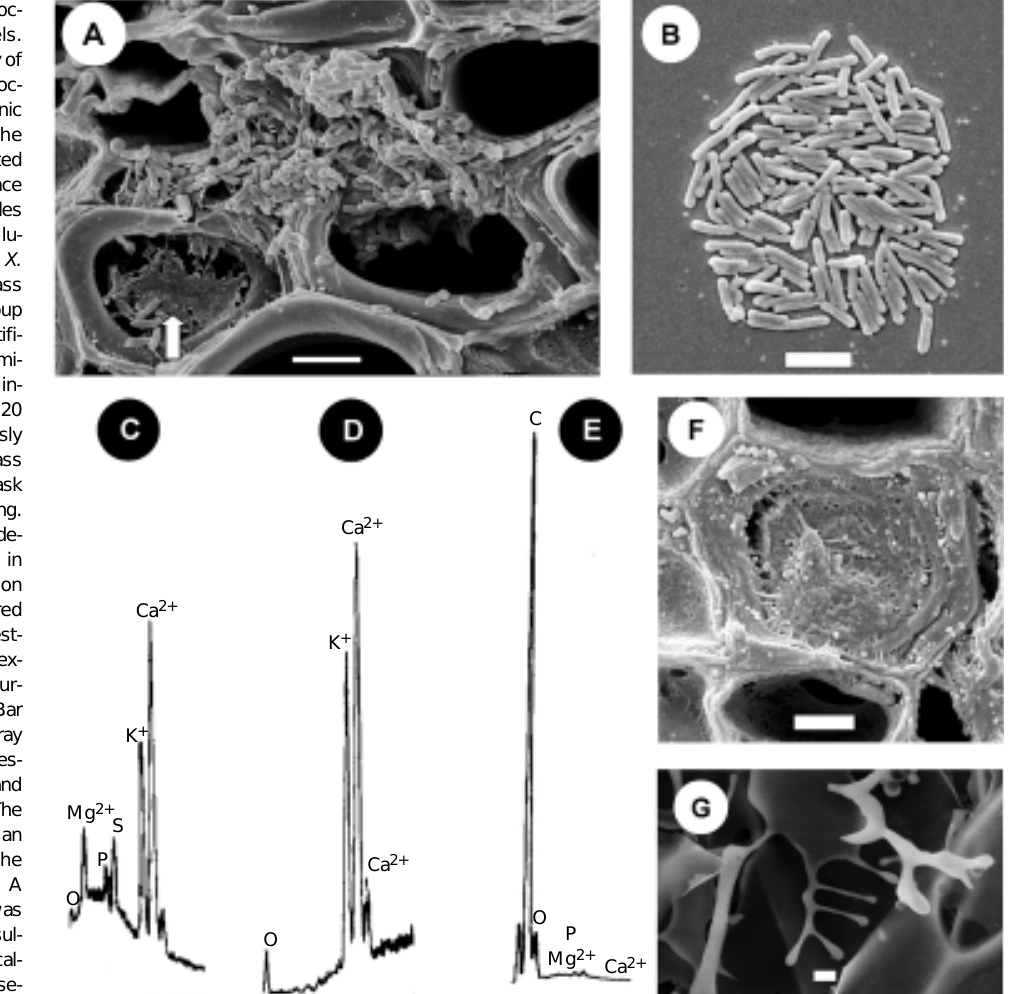
Figure 1. A , Xyllela fastidiosa oc- cluding citrus xylem